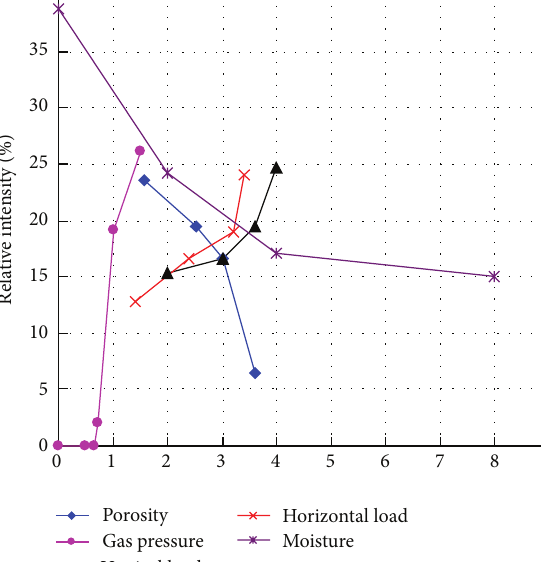
Figure 6: Factors increment versus relative intensity